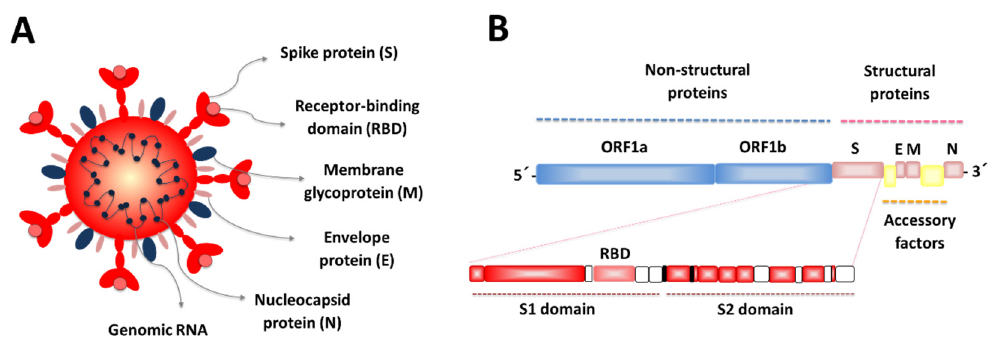
Figure 1. SARS-CoV-2 virion ( A ) and genome ( B ) structures. The virion contains a nucleocapsid composed of genomic RNA and N protein, which is enclosed inside the virus envelope consisting of S, E and M proteins. Approximately two-thirds of the RNA genome encodes a large polyprotein (ORF1a/b), while the last third proximal to the 3 ′ -end encodes four structural proteins: spike (S), envelope (E), membrane (M) and nucleocapsid (N). The structure of the S-protein showing the S1 and S2 domains and the receptor-binding domain (RBD) are highlighted.